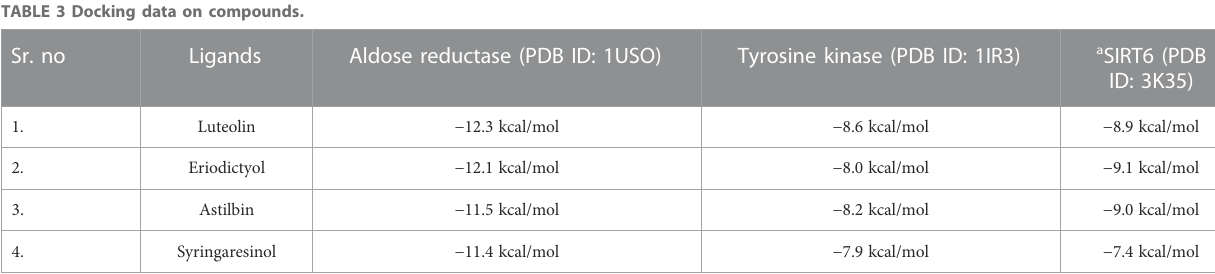
TABLE 3 Docking data on